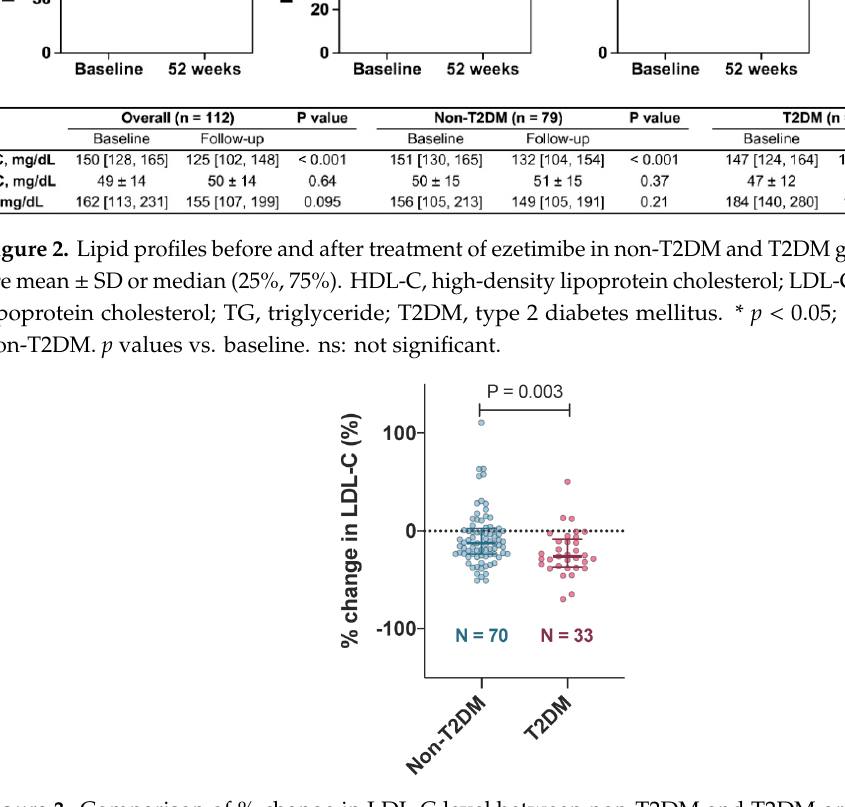
Figure 3. Comparison of % change in LDL-C level between non-T2DM and T2DM groups. LDL-C, low-density lipoprotein cholesterol; T2DM, type 2 diabetes mellitus. Bars represent median (25%, 75%).